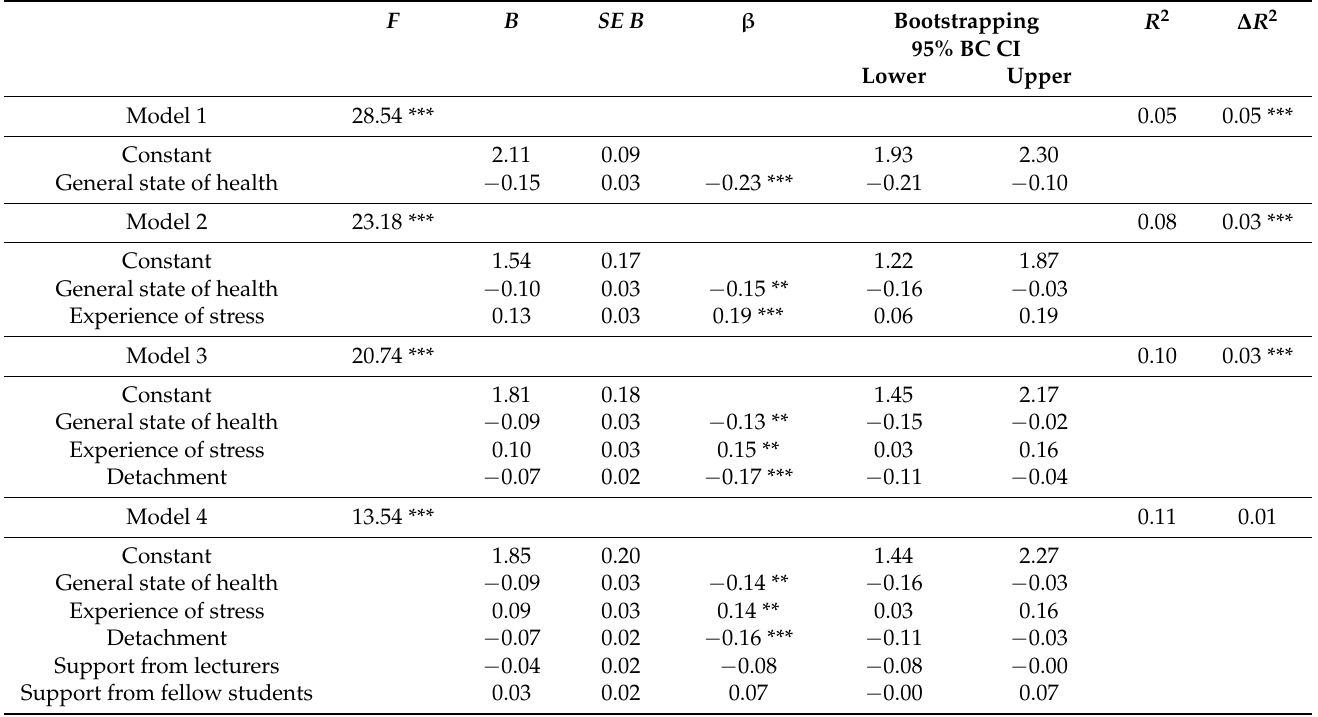
Table 6. Hierarchical linear regression